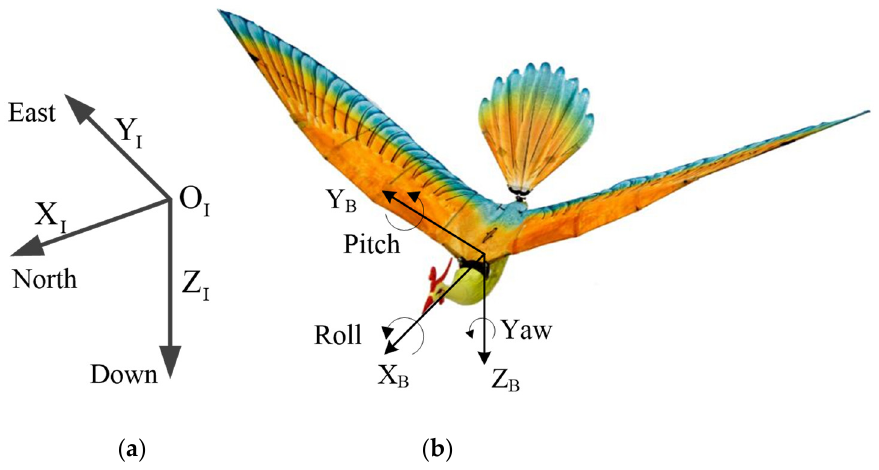
Figure 8. Schematic diagram of inertial frame and body system orientation. ( a ) Schematic diagram of inertial system. ( b ) Schematic diagram of body system.